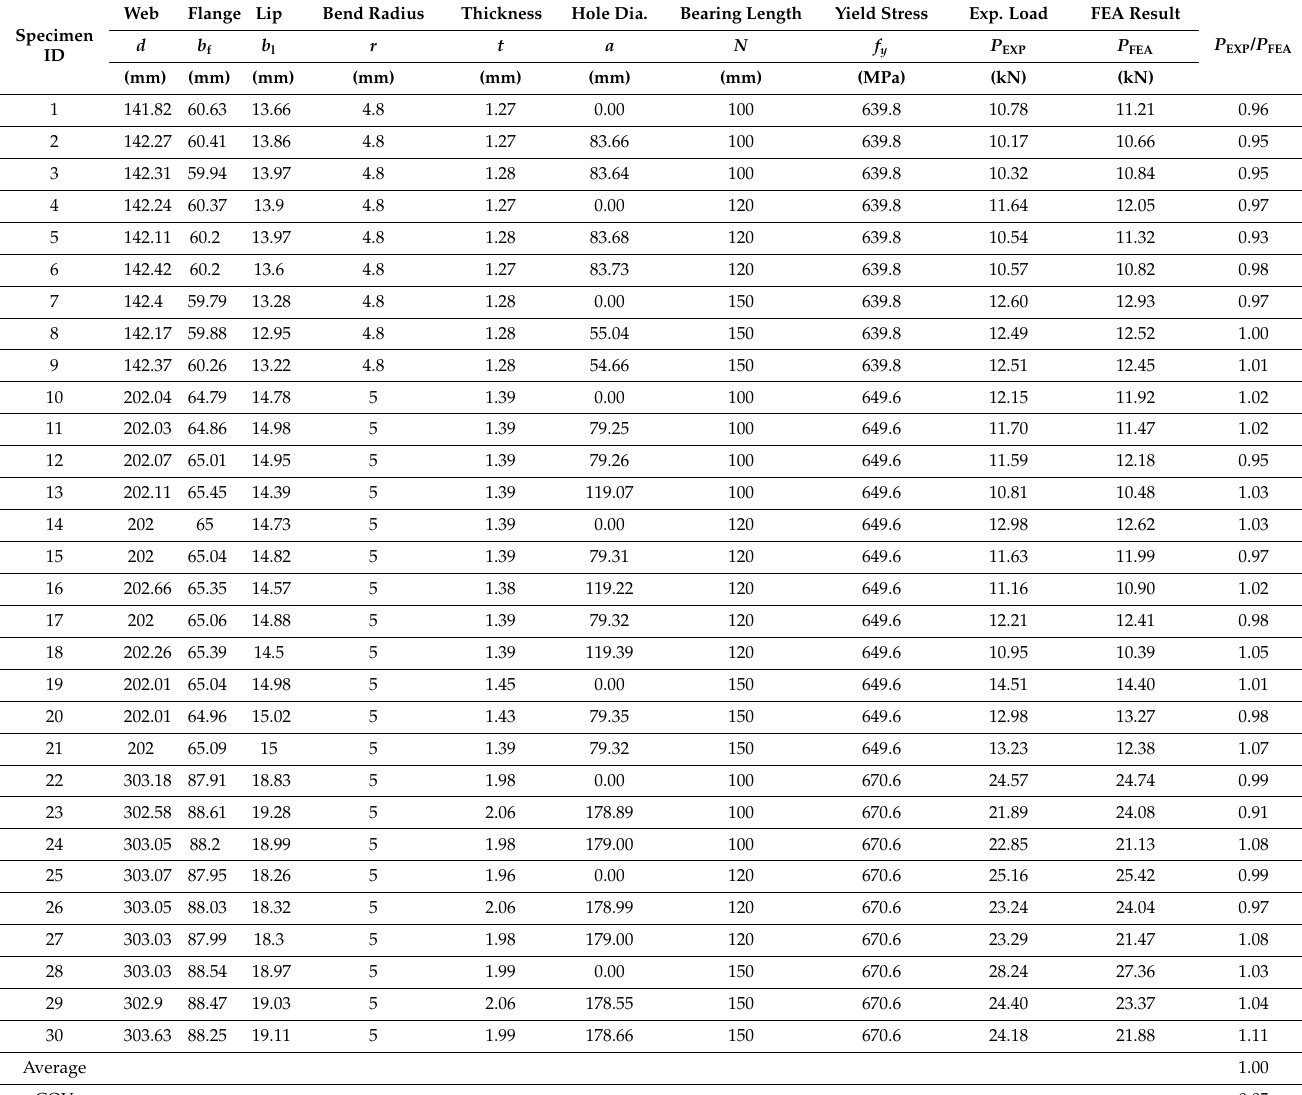
Table 1. Comparison of experimental results with FEA results for sections with unfastened flanges.